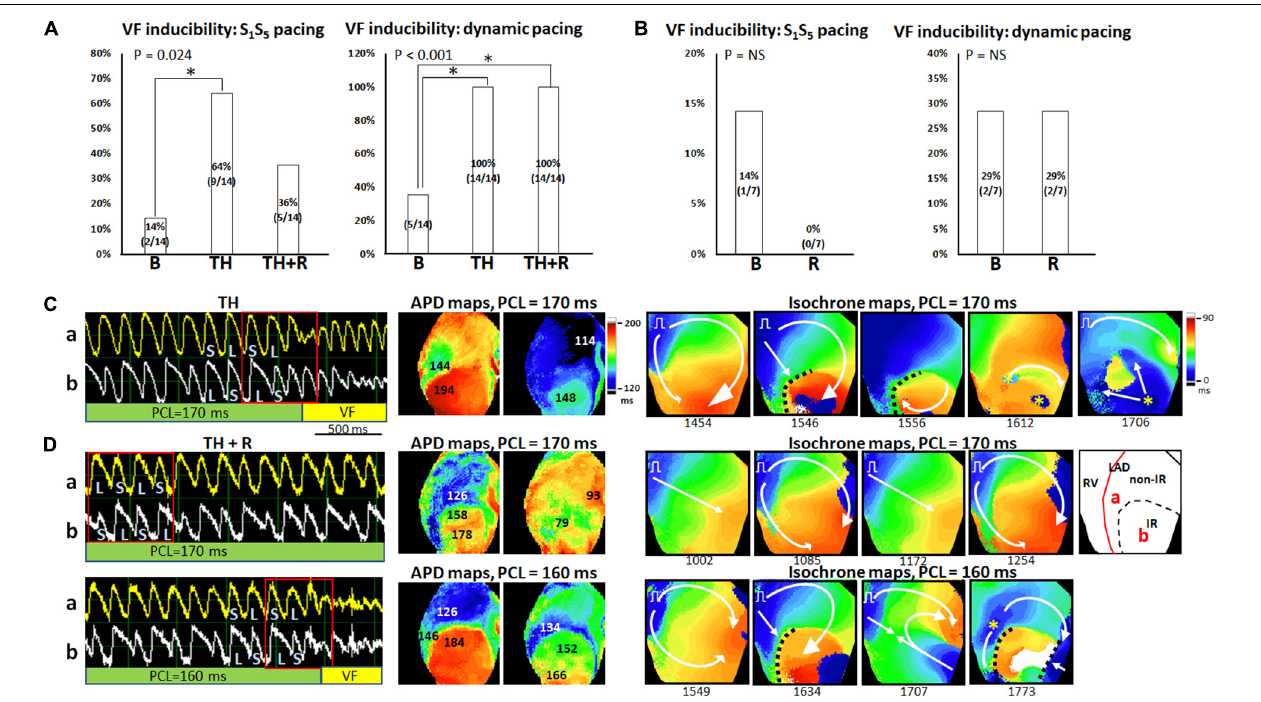
FIGURE 7 | Effects of therapeutic hypothermia (TH) and rotigaptide (R) on ventricular fibrillation (VF) induction. (A,B) Summarized results of VF inducibility in the TH ( n = 14, Fisher’s exact test and post hoc Bonferroni analysis) and non-TH groups ( n = 7, Fisher’s exact test), respectively. A single asterisk indicates P < 0.05. (C) A representative example of VF induction during TH of the same heart in Figure 6A . Left: Vm tracing showing VF initiation at PCL = 170 ms in the TH group. S, short; L, long. Middle: APD maps showing large APD gradients at the sites of conduction block. Right: isochrone maps of VF initiation corresponding to Vm tracing labeled by a red square. (D) VF induction after rotigaptide administration. Upper: At PCL of 170 ms, Vm alternans was out-of-phase between site a and site b. APD maps showed smaller APD gradients at the sites of conduction block. Isochrone maps show the beat-to-beat alternation of conduction velocity. Right subpanel: schematic of the mapping field. Lower: VF induction at PCL of 160 ms. Large APD gradients were induced at the sites of conduction block. White arrows indicate the directions of wavefront propagation; dashed black lines indicate the functional conduction block; yellow asterisks, epicardial